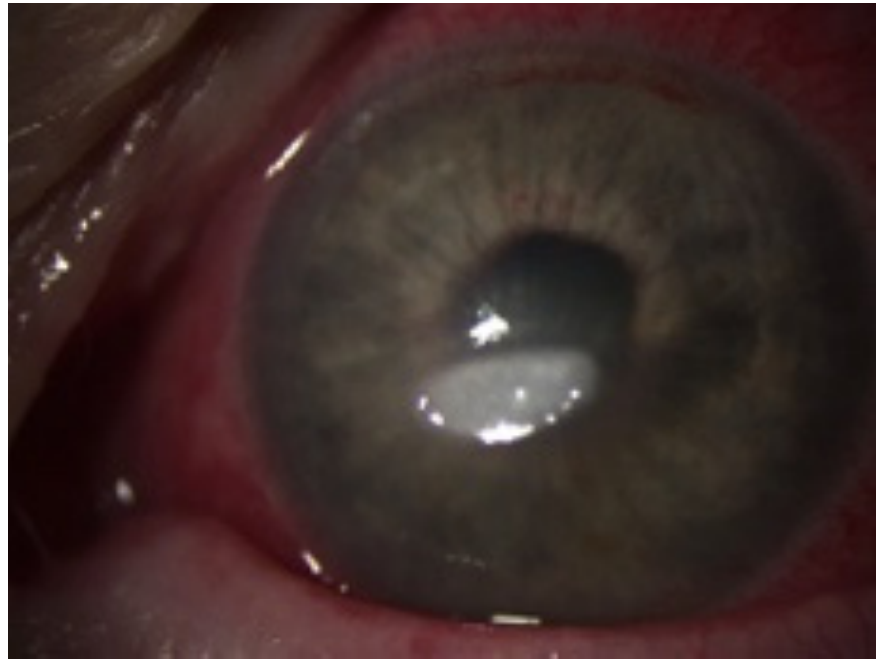
Figure 1. Biomicroscopic slit-lamp photography of the left eye upon inpatient admission. Clinical findings demonstrated a white, gelatinous paracentral corneal infiltrate (3.0 × 1.5 mm) and discrete peripheral infiltration (0.5 mm) at 10 o’clock.